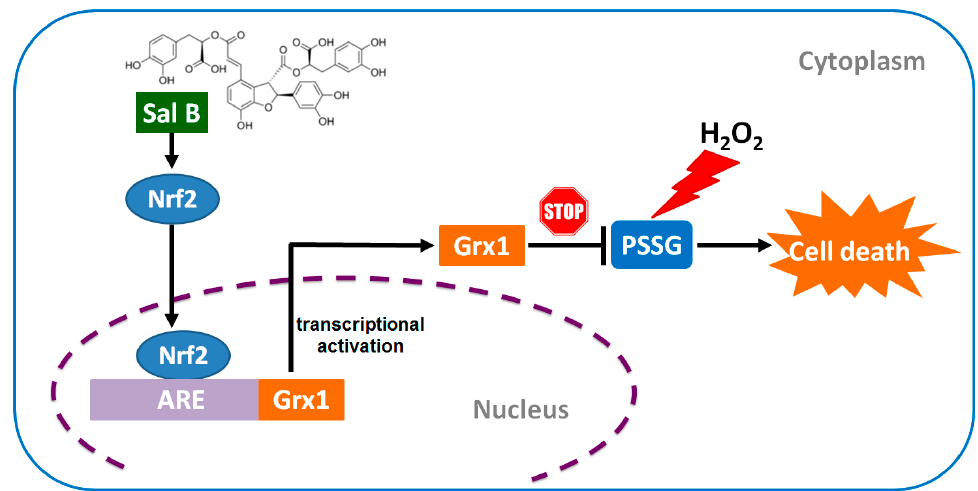
Figure 8. Sal B protected RPE cells by Grx1 induction though activating the Nrf2 pathway. Sal B in RPE cells acts upon Nrf2, causing Nrf2 expression to increase in the cell and translocate to the nucleus. Nrf2 binds to the antioxidant response element (ARE), causing the activation of Grx1 transcription. Grx1 up-regulation enhances cell survival due to an improved redox state and prevention of PSSG accumulation in RPE cells.